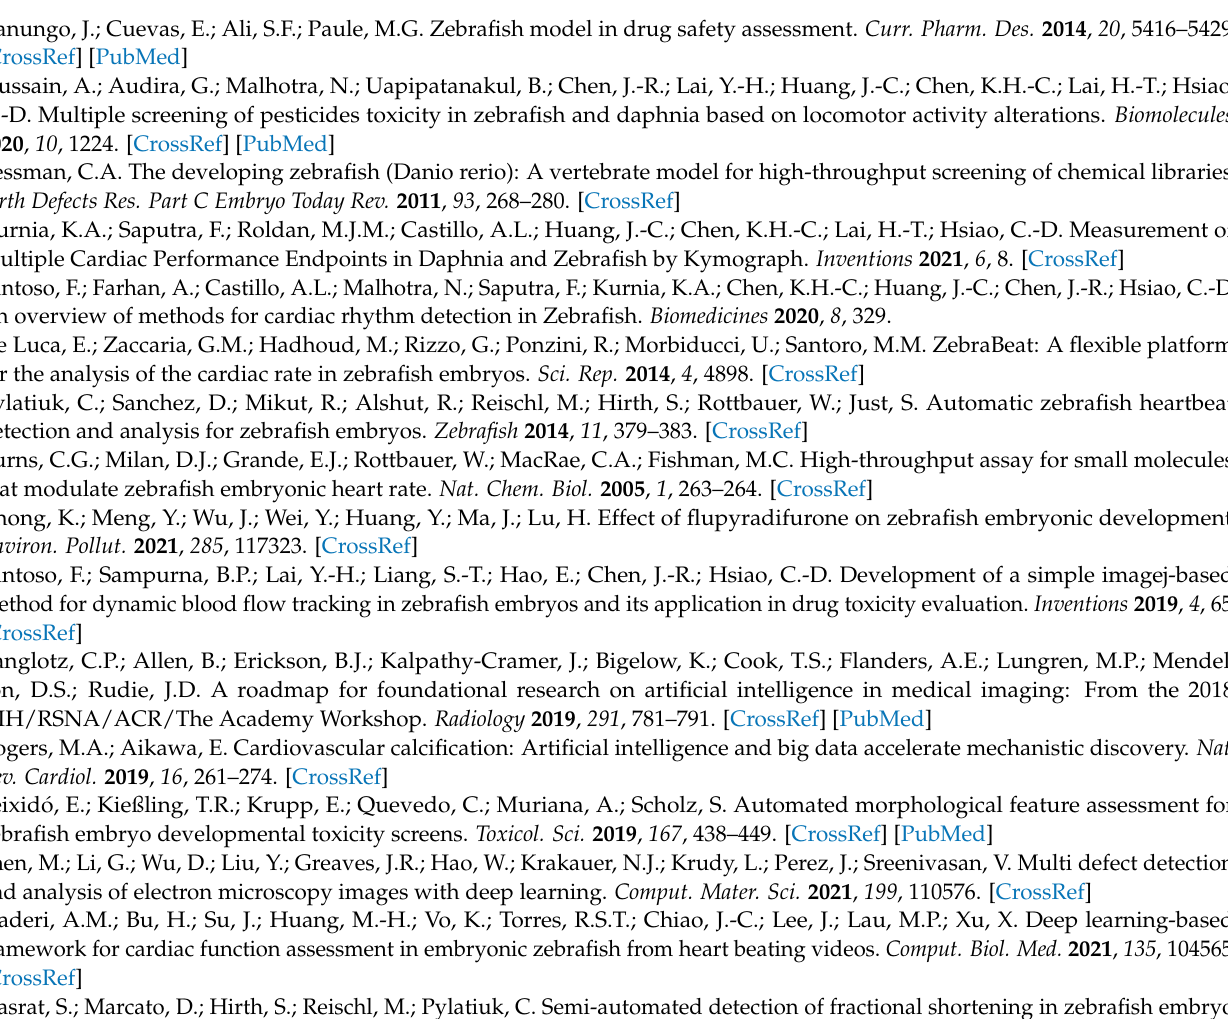
Figure A3. Comparison of the dynamic volume change patterns extracted from zebrafish heartbeat between control (black color), ethanol (EtOH) 2% (purple color), and ponatinib 2.5 ppm (green color)-treated groups.